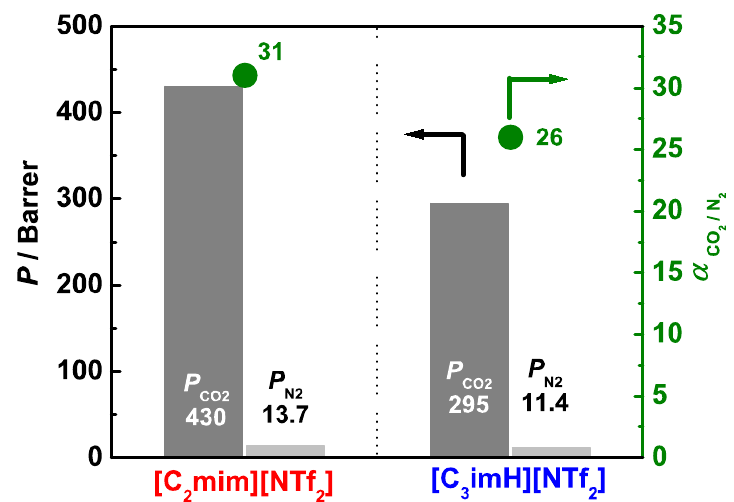
Figure 3. Permeability coefficients for CO 2 and N 2 gases ( P CO2 and P N2 , respectively), and CO 2 selectivity ( α ) for AIL [C 2 mim][NTf 2 ]/SPI and PIL [C 3 imH][NTf 2 ]/SPI composite membranes.